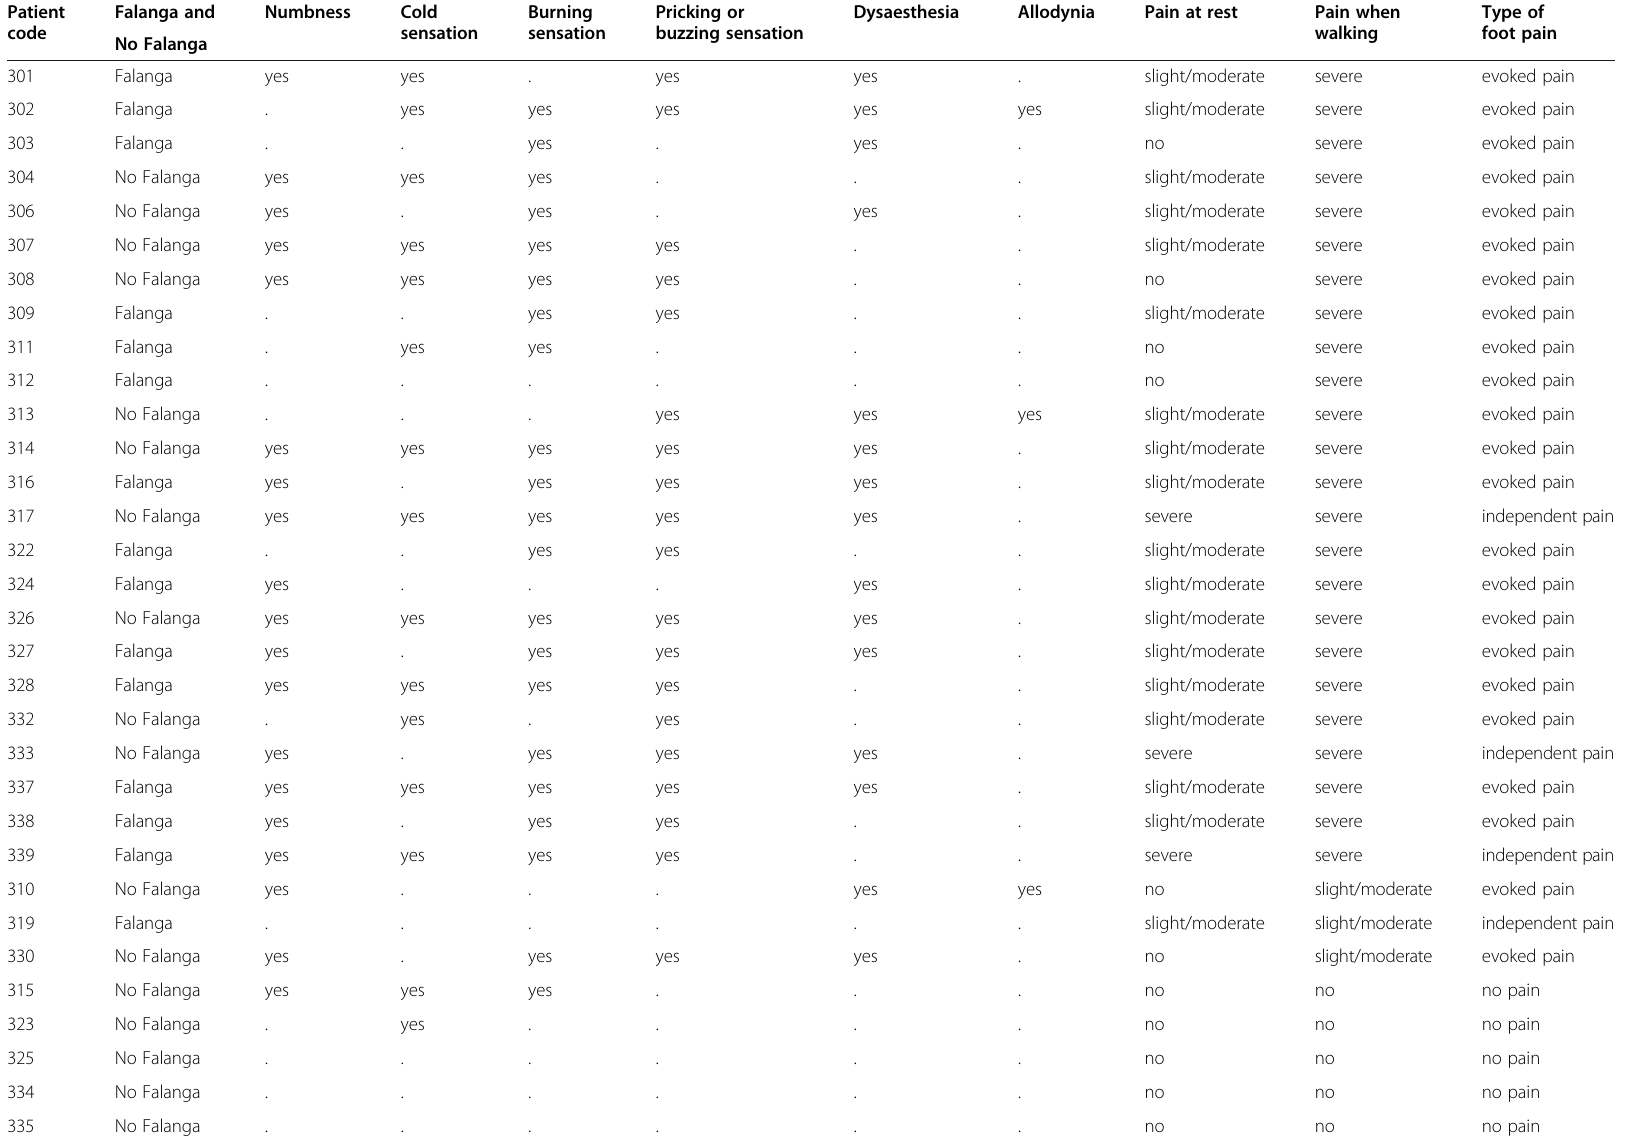
Table 1 Reported pain, sensory symptoms, pain at rest, pain when walking and type of foot pain sorted by ‘ pain when walking ’ in the left foot sole of 32 torture victims (blank space=normal) Patient Falanga and code